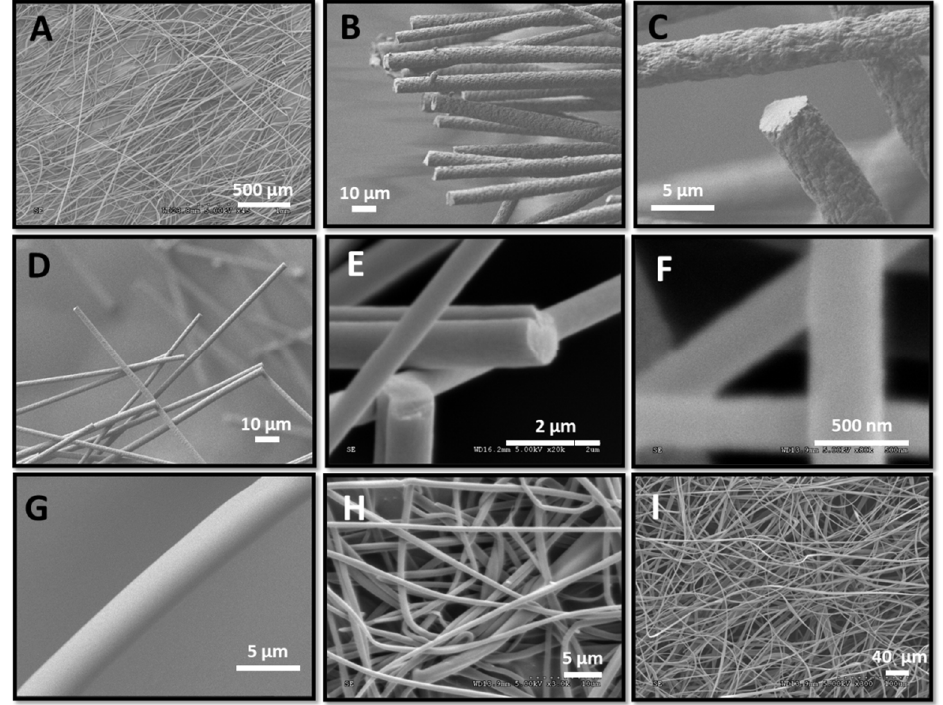
Figure 3. SEM pictures of the fibers ( A ) expt. 1. ( B ) expt 2. ( C ) expt. 3. ( D ) expt 4. ( E ) expt 5. ( F ) expt 6. ( G ) expt 7. ( H ) expt 8. ( I ) expt 12.